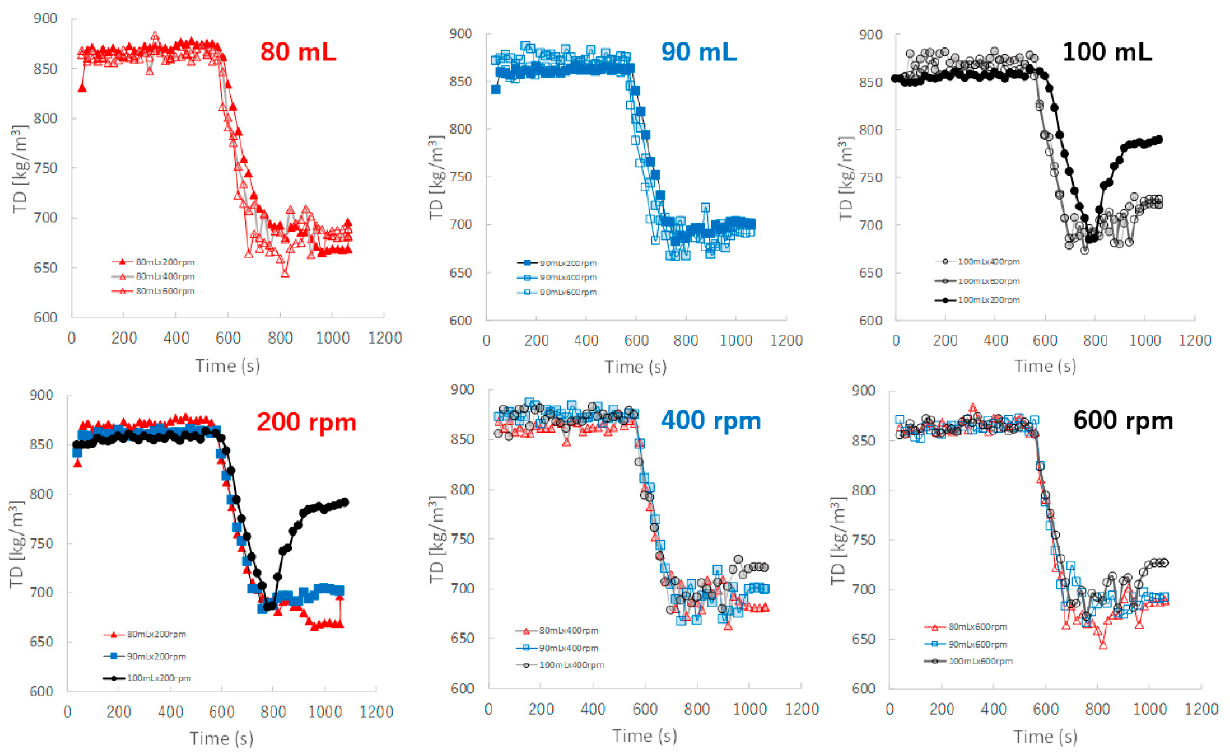
Figure 9. The effect of adding water and increasing stirring speed on real-time TD profiles of the granules predicted using the NIRS/PLSR method.